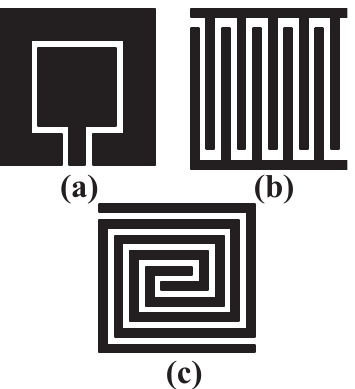
Figure 5. ( a ) square-shaped pattern; ( b ) interdigital pattern; ( c ) spiral